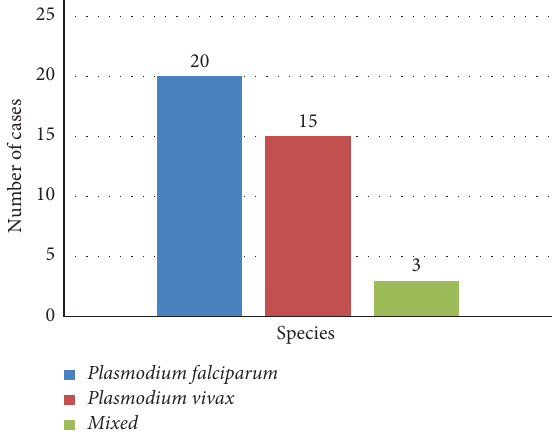
Figure 1: Cases of Plasmodium infection identifed by light mi- croscopy and rapid diagnostic